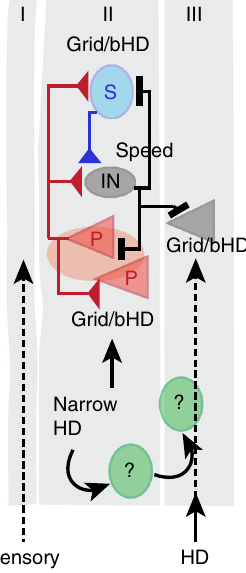
Fig. 10 Responses of different functional mEC cell types to LII